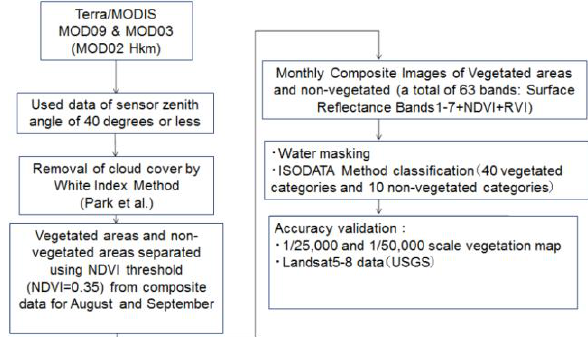
Figure 1. Flowchart for constructing vegetation maps from